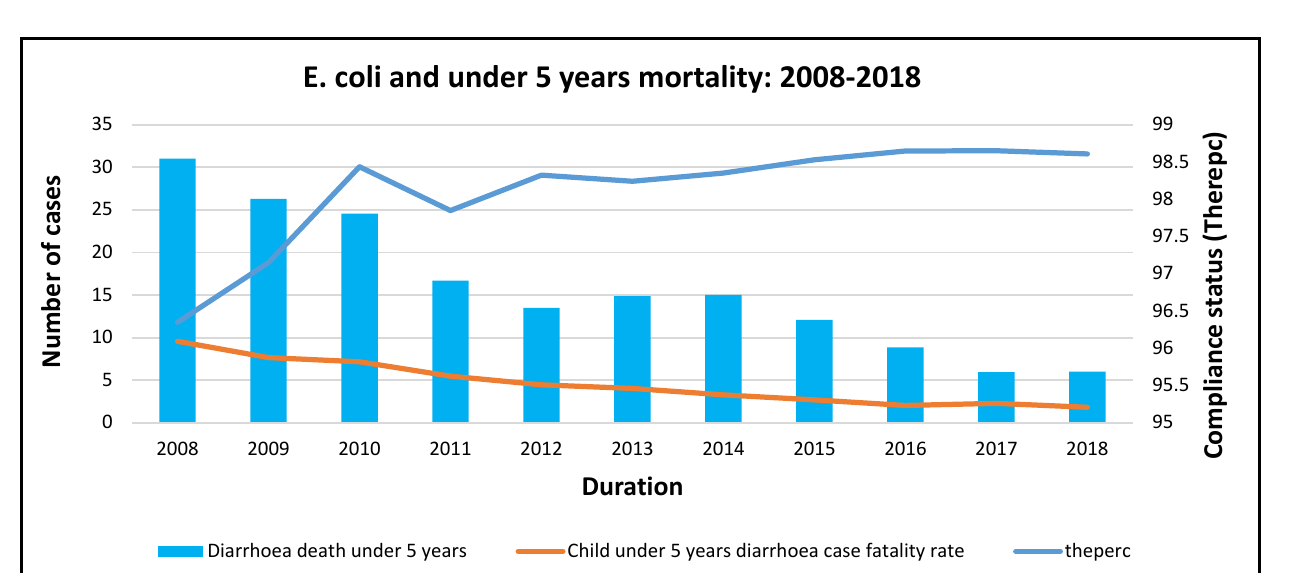
tality rate, and compliance increased from 2012 to 2018. This was associated with a drastic decrease in under 5 years mortality (Figure 6).